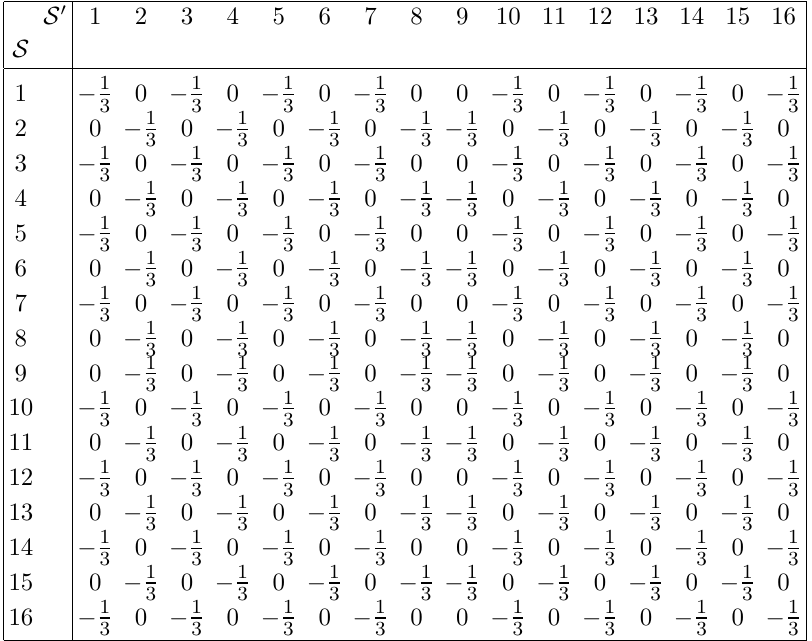
(cid:2) P with di(cid:11)erent boolean factors. [3] [6]